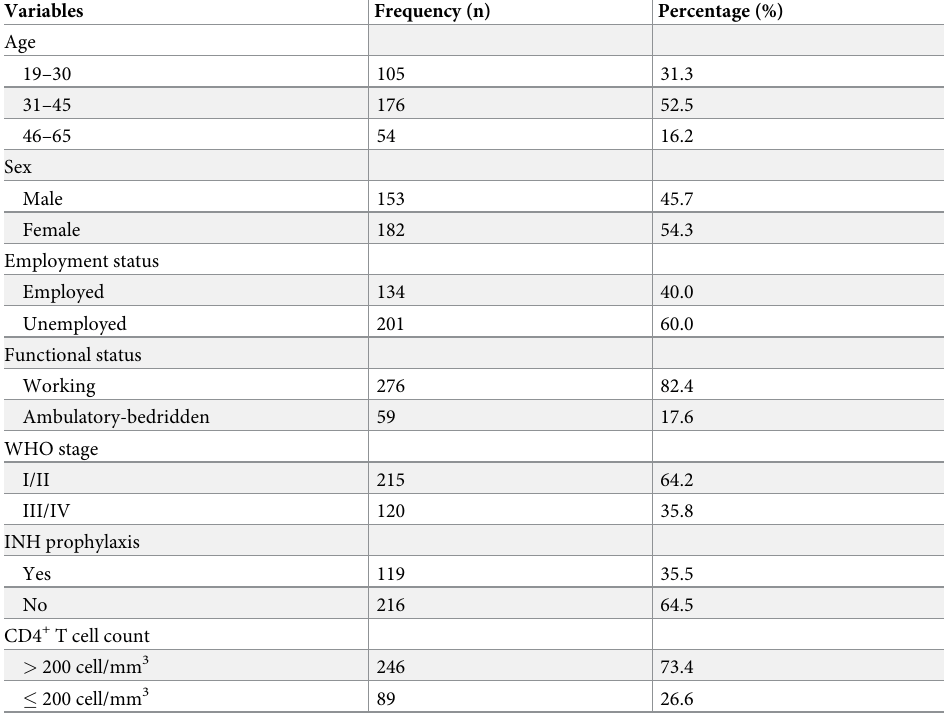
Table 1. Baseline demographic and clinical profiles of study participants living with HIV in